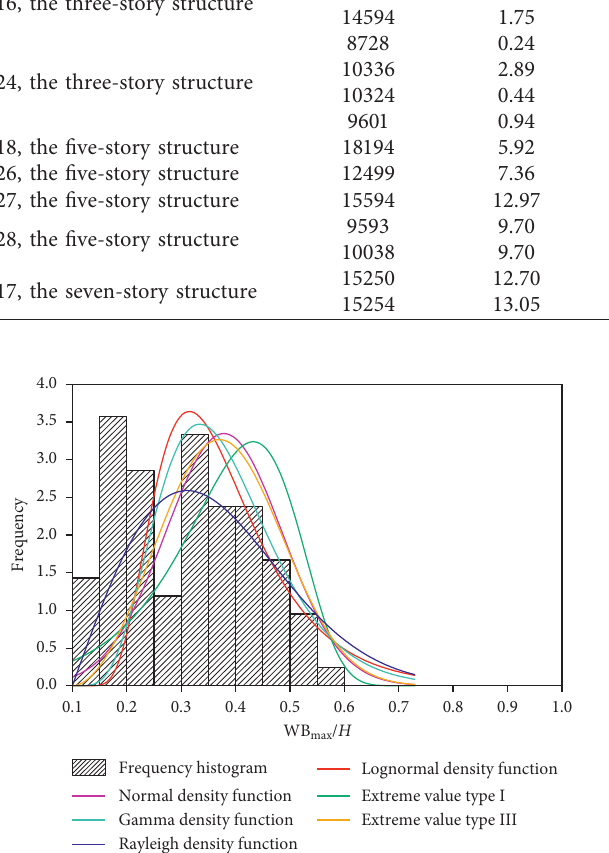
Figure 18: Frequency histogram along the Z axis and assumed distribution density functions.